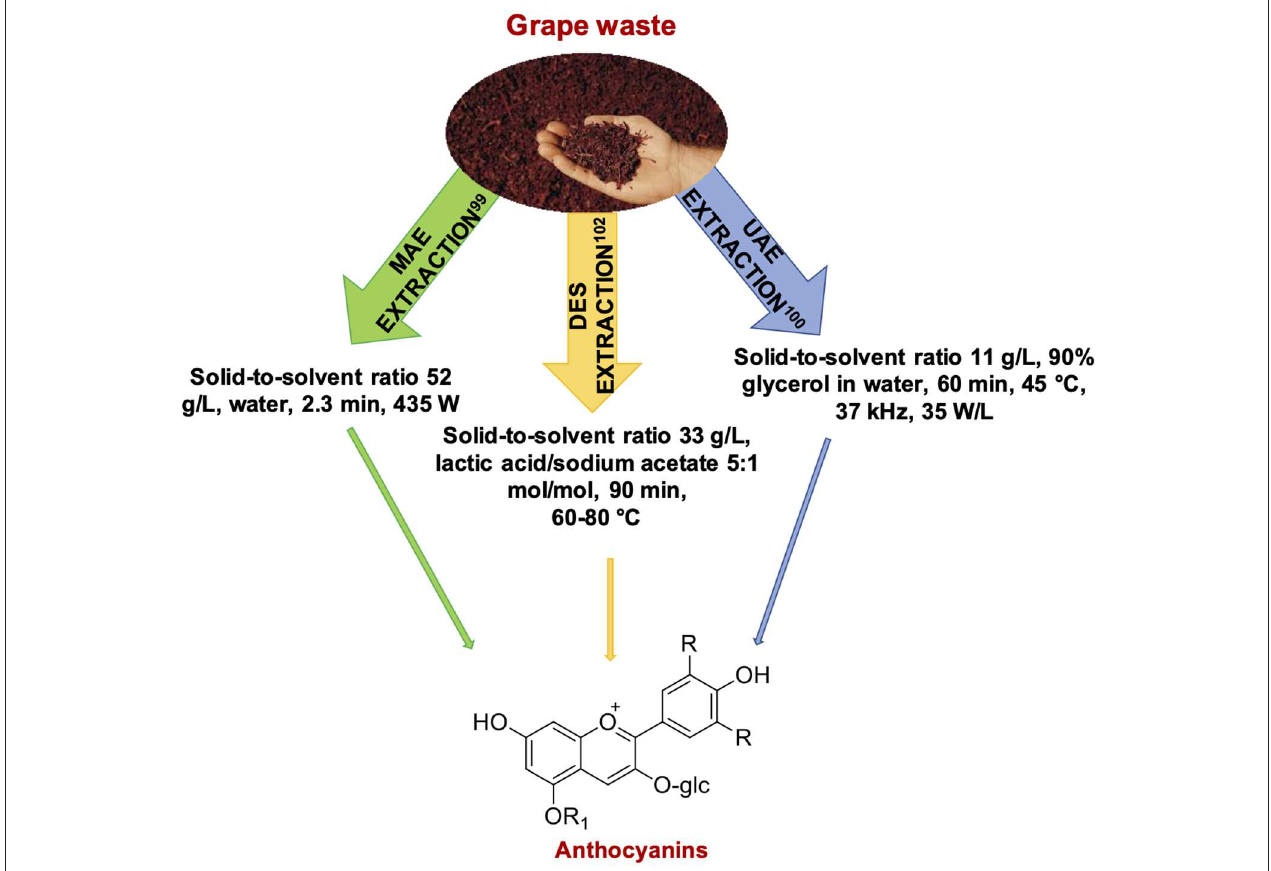
FIGURE 7 | Representative examples of phenolic compounds recovered from grape